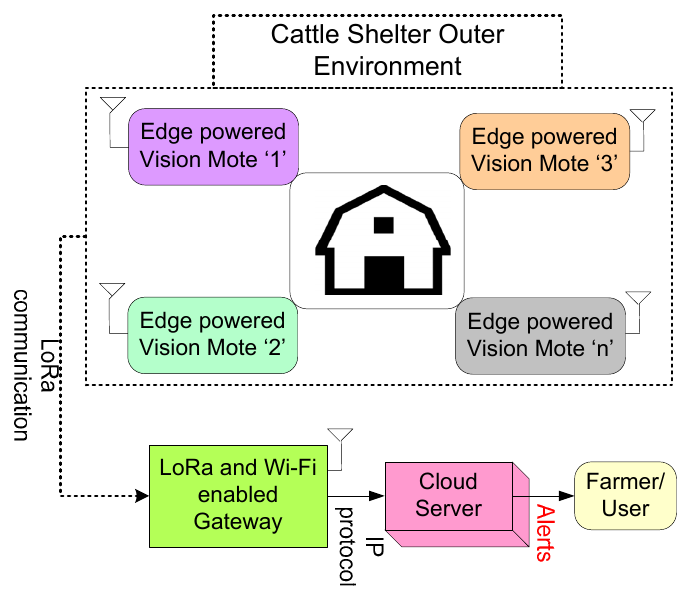
Figure 6. Edge computing and IoT enabled system for the safety of cattle.